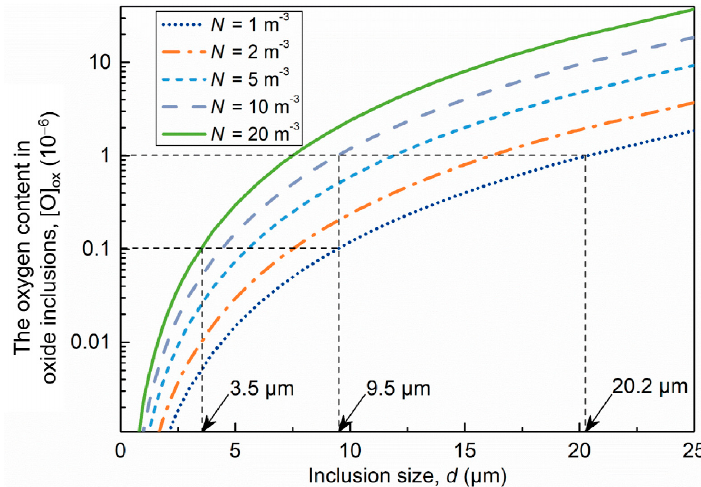
Figure 12. The effect of the harmonic average size of inclusions d and the volume number density of inclusions N v on the variation of [O] ox .